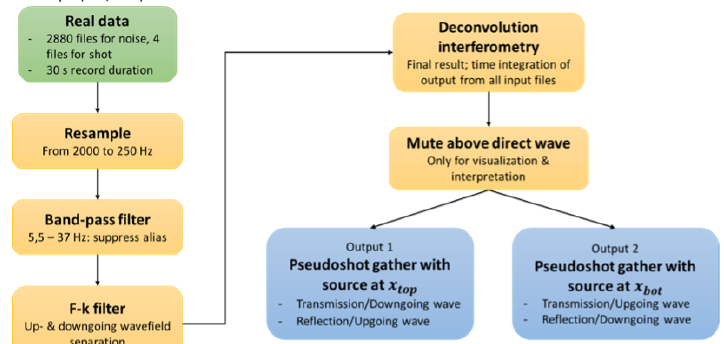
Figure 6. Processing flowchart of transmission and reflection response estimation using interferome- try with a virtual source at the top (output 1) and bottom geophone (output